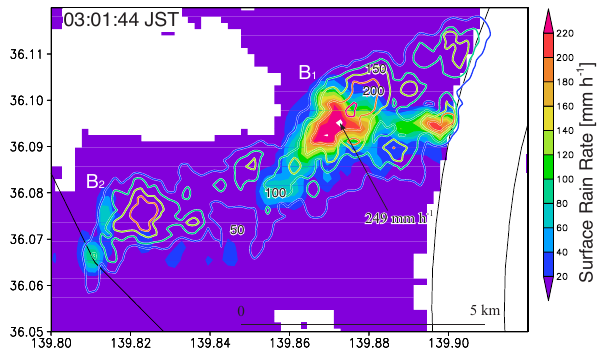
Fig. 14. The horizontal distribution of VMI( R ) superimposed over the rainfall rate on the ground estimated from the MRI C-band polarimetric radar at 03:01 JST. The arrow indicates the location of the estimated maximum rainfall rate on the ground, and the colored contours indicate VMI( R ) from 50 mm h -1 with a contour interval of 50 mm h -1 .